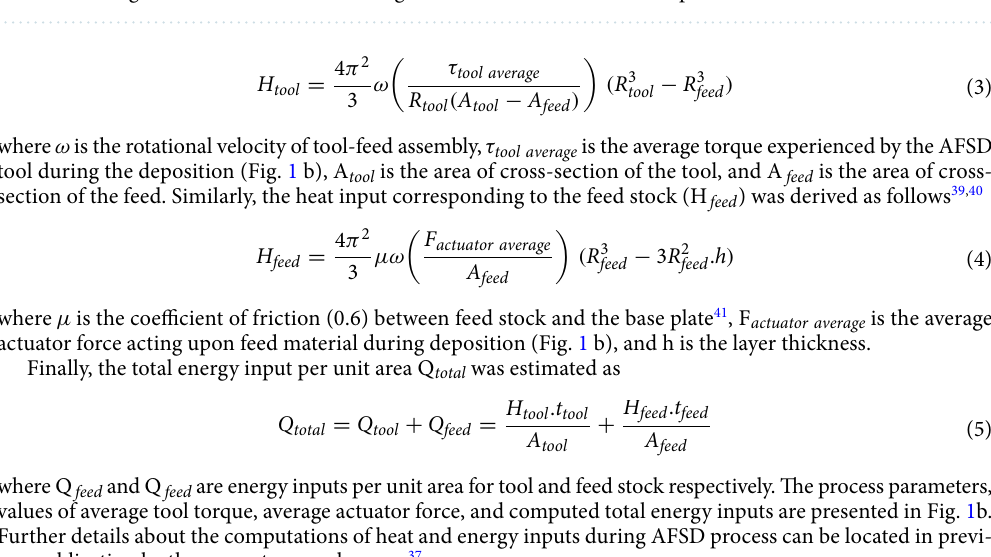
Figure 1. Schematics of ( a ) the AFSD process, ( b ) important AFSD process parameters and attributes employed in the current work, ( c ) non destructive testing via EBME Method, and ( d ) location of tensile specimen machined along tool traverse direction through the thickness of the AFSD